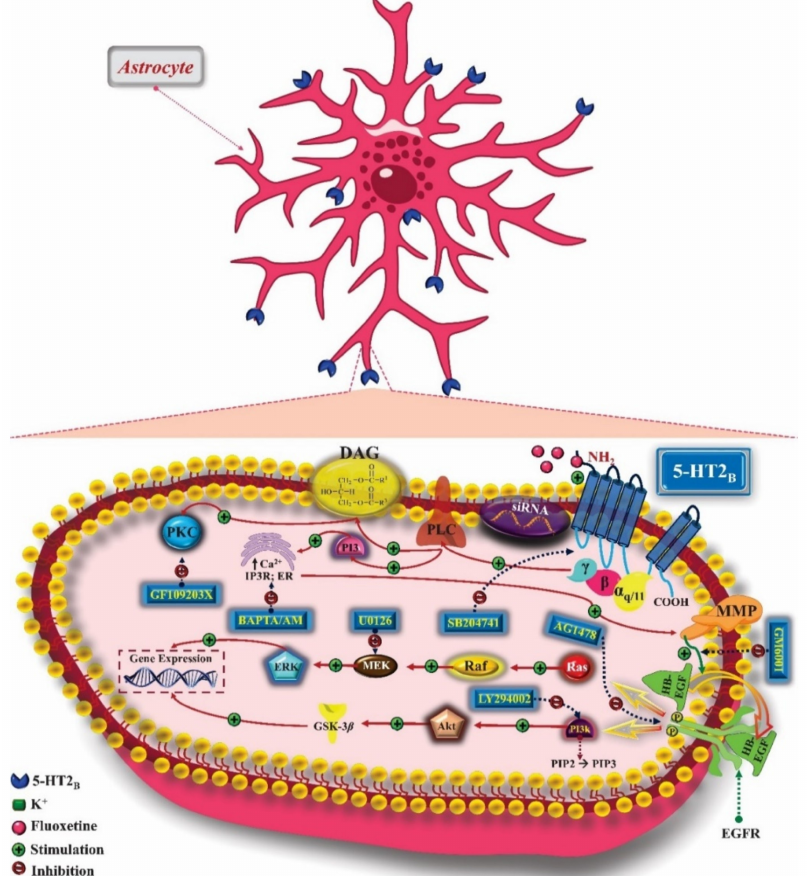
Figure 6. Scheme of pathways that stimulate extracellular signal-regulated kinase (ERK) and phospho- rylate protein kinase B (AKT) after stimulation of the 5-HT 2B receptor by fluoxetine in astrocytes. Flu- oxetine binds and activates 5-HT 2B receptors, culminating in the stimulation of G α q/11 protein, which stimulates enzyme phospholipase C (PLC), which catalyzes the hydrolysis of phosphatidylinositol- 4,5-bisphosphate in inositol 1,4,5-triphosphate (IP3) and diacylglycerol (DAG). DAG induces protein kinase C (PKC) activity, while IP3 increases the intracellular calcium (Ca 2+ ) concentration due to the release of Ca 2+ from endoplasmic reticulum stocks. Ca 2+ stimulates zinc-dependent metallopro- teinases (MMPs) and leads to the release of growth factors. The released epithelial growth factor receptor (EGFR) ligand stimulates EGFR phosphorylation. ERK, the downstream target of EGFR, is phosphorylated via the Ras/Raf/MEK pathway, and AKT is phosphorylated via the phosphoinosi- tide 3-kinase pathway (PI3K). In addition, PIK3 catalyzes the formation of PIP3 from PIP2. After fluoxetine administration, ERK and AKT phosphorylation was blocked when iRNA against the 5-HT 2B receptor was administered or after administration of inhibitors of this receptor (SB204741) (shown in blue), PKC (GF109293X), intracellular Ca 2+ homeostasis (BAPTA/AM, an intracellular Ca 2+ chelator), zinc-dependent MMPs (GM6001), EGFR (AG1478), ERK phosphorylation (U0126, a mitogen-activated protein Kinase (MEK) inhibitor), or AKT pathway (LY294002, a PI3K inhibitor)